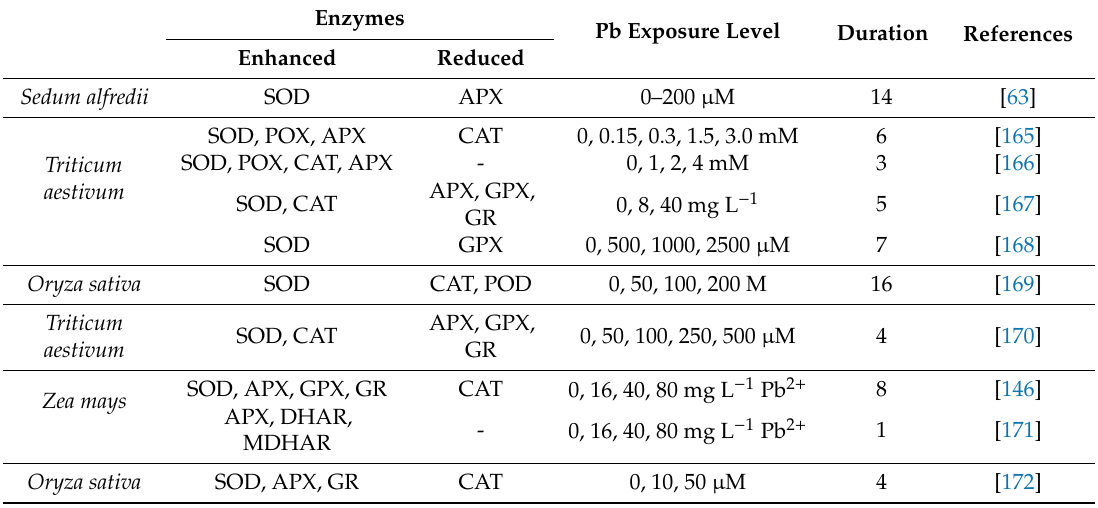
Table 4. E ff ects of Pb toxicity on activities of di ff erent antioxidant enzymes in di ff erent plants [16].